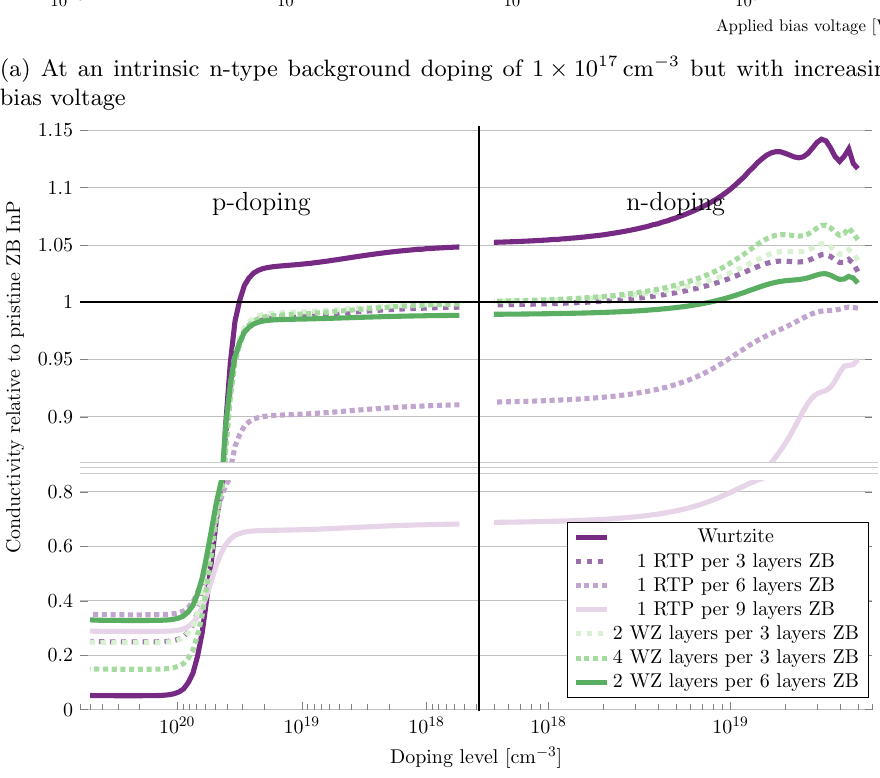
high doping levels. Figure 6. Differential conductivity of InP phase-defect systems along the [111]/[0001] crystallographic direction, relative to a pristine ZB